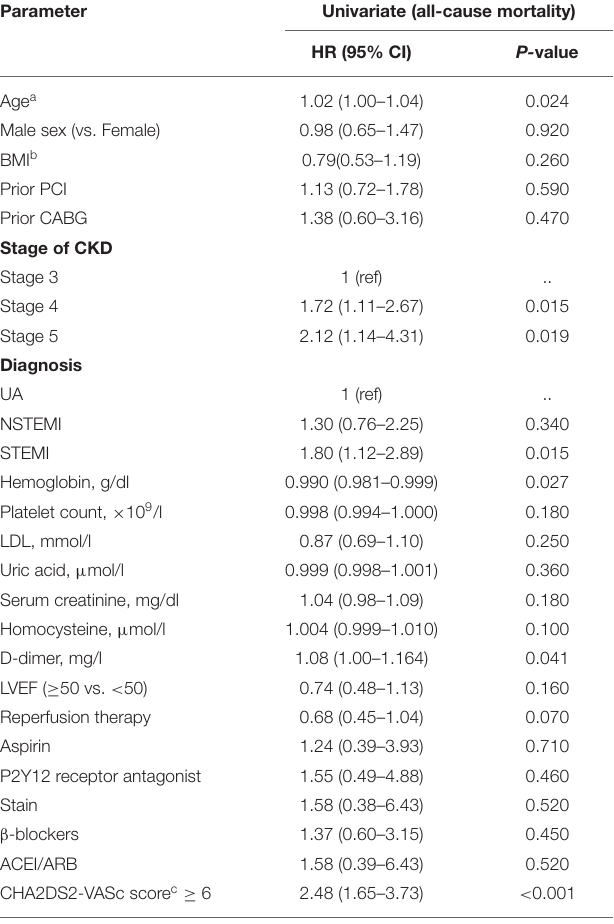
TABLE 2 | Cox regression analysis of factors related to all-cause mortality. Parameter